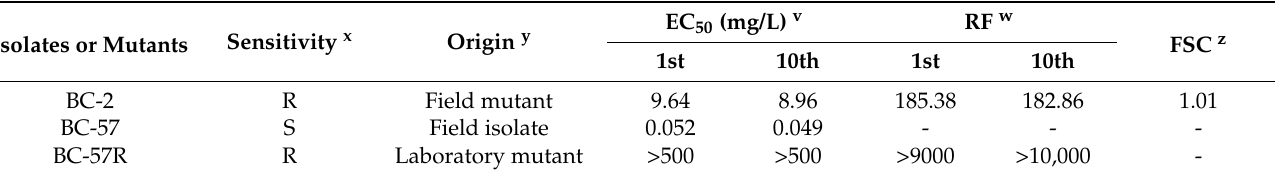
Figure 1. Sensitivity of wild strain and two fludioxonil-resistant strains of Botrytis cinerea strains after three days of growth on PDA amended with 5 and 10 mg/L fludioxonil. Table 1. Stability and level of the fludioxonil resistance for the laboratory and field isolates of Botrytis cinerea.